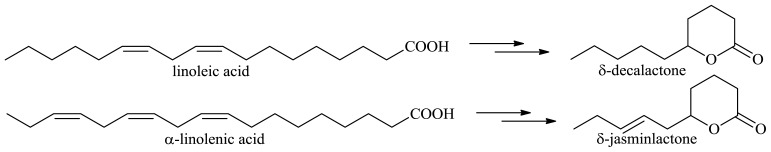
Formation of saturated δ-lactones from unsaturated fatty acids.